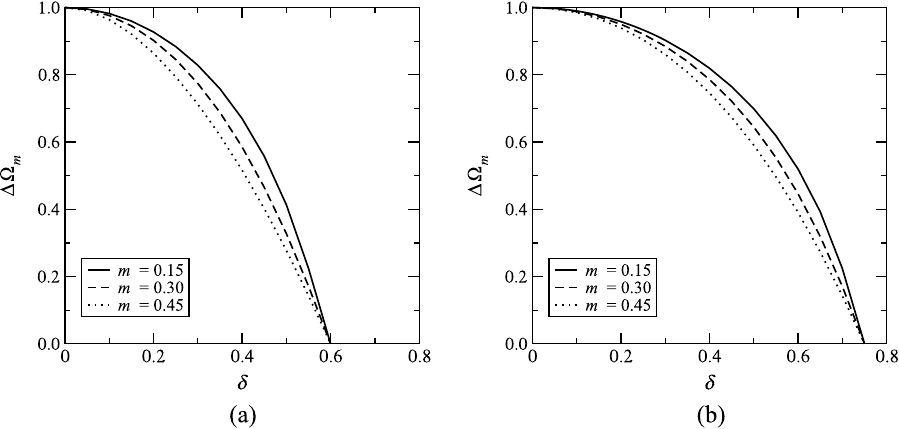
Figure 3. Width of the upper/lower gap Δ Ω m as a function of velocity δ for different values of m . ( a ) κ = 10, c = 0.2; ( b ) κ = 5, c =